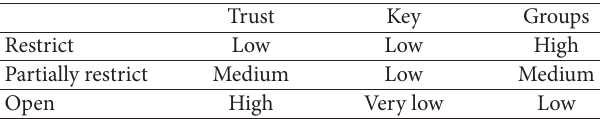
Table 2: Expected communication overhead. Trust